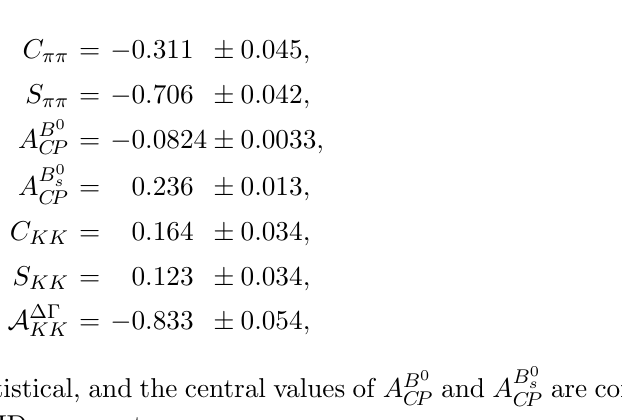
Figure 4 . Distributions of (top left) K + K (cid:0) invariant mass, (top right) B 0 fractions (bottom left) (cid:17) OS and (bottom right) (cid:17) SS K for K + K (cid:0) candidates. The result of the simultaneous (cid:12)t is overlaid. The various components contributing to the (cid:12)t model are drawn as stacked